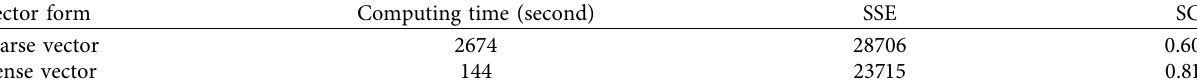
Figure 10: Eleven mobility patterns recognized by the proposed method when δ � 8 and ε � 10. (a) POI categories around the origin station. (b) POI categories around the destination station. (c) The start time of the day. (d) The day of week. (e) Travel time. Table 4: Comparison of results with different vector forms.